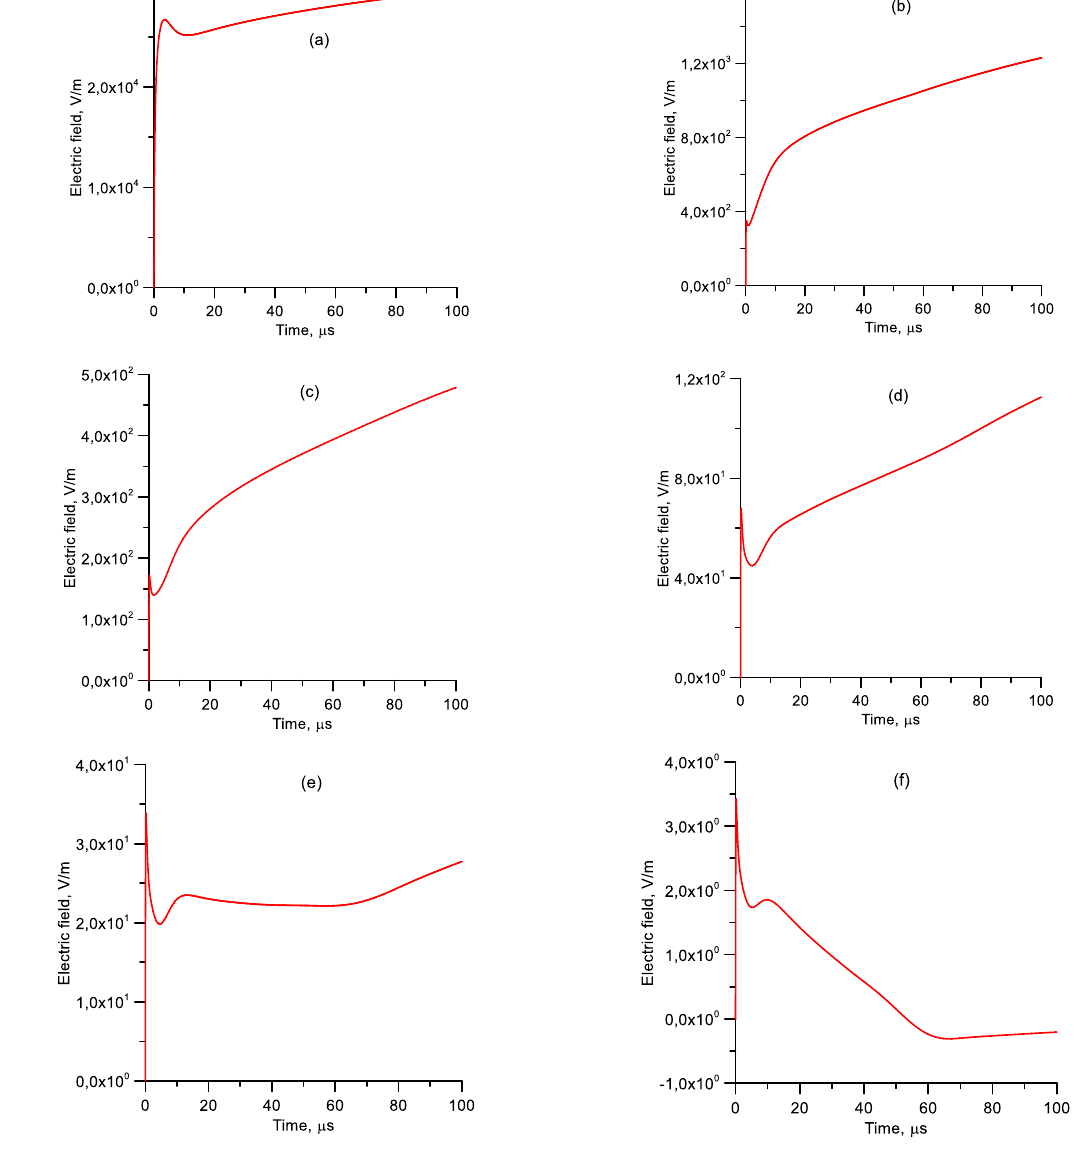
Figure 8. Electric field of subsequent return strokes at different distances as predicted by the MTLD model that incorporates current dispersion. ( a ) 50 m, ( b ) 1 km, ( c ) 2 km, ( d ) 5 km, ( e ) 10 km and ( f ) 100 km. The return stroke speed is assumed to be constant and equal to 1.5 × 10 8 m/s.